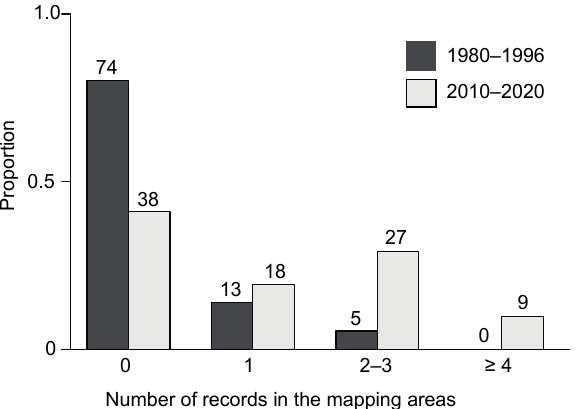
Figure 4. Frequency distribution of Lamium galeobdolon subsp. argentatum records in 92 mapping areas in the region of Basel (Switzerland) in the years 1980–1996, and in 2010–2020.